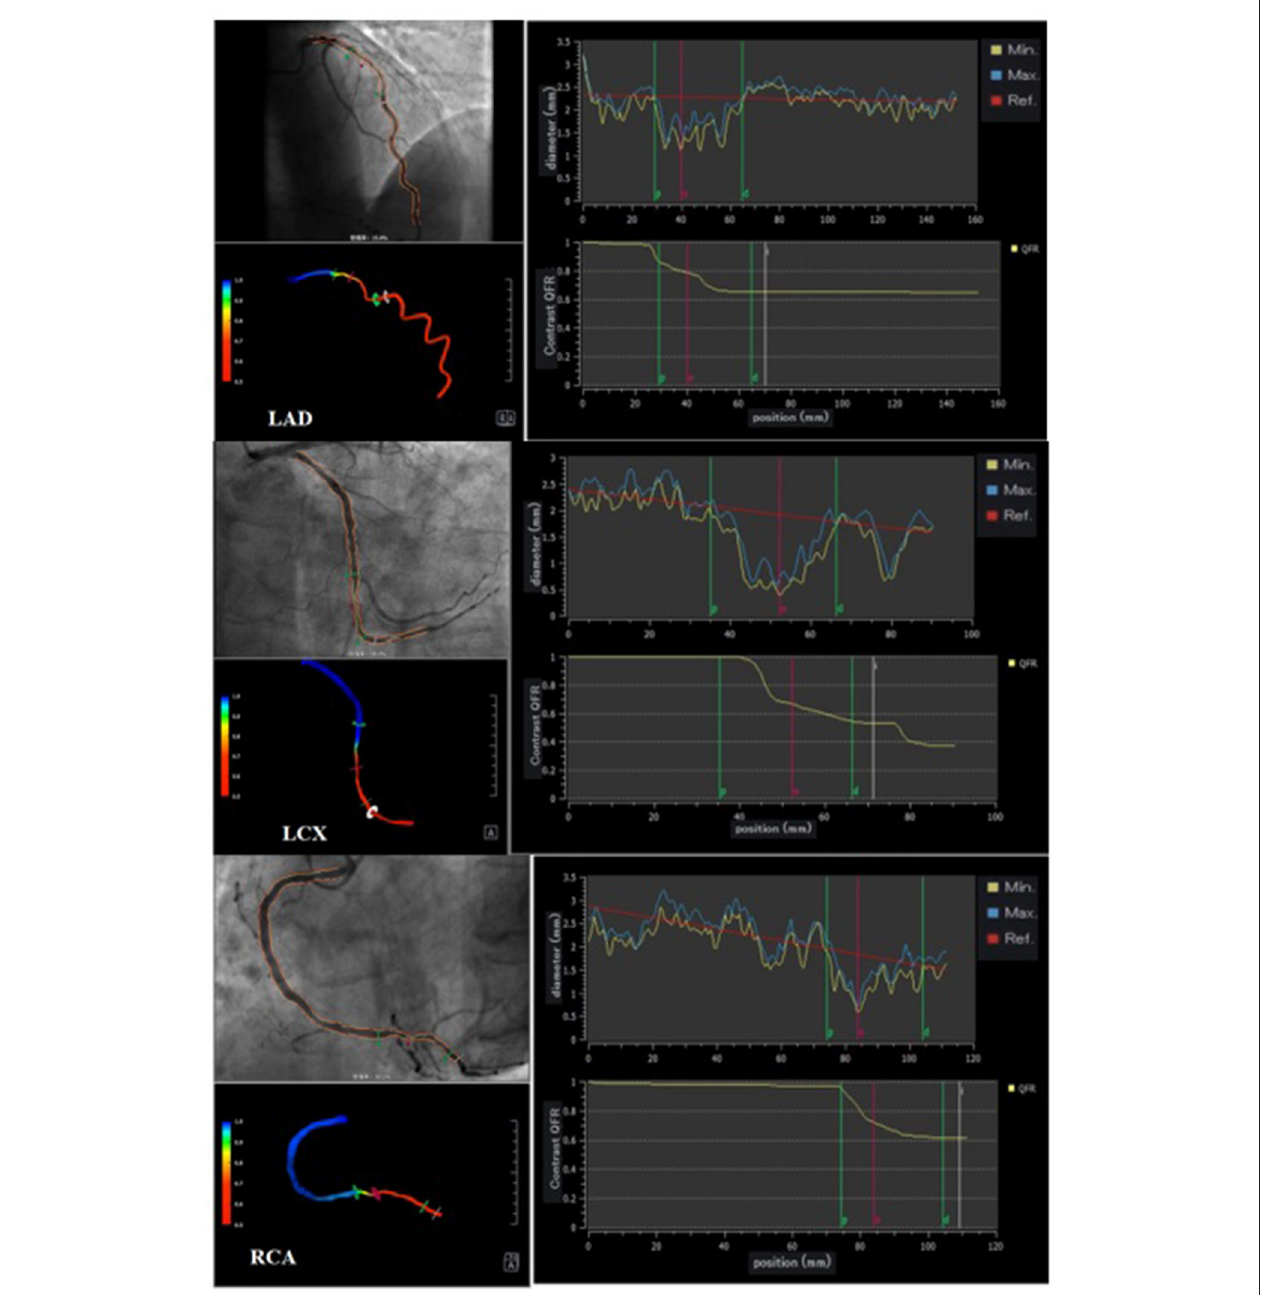
FIGURE 1 | Representative cQFR analysis. Three representative cases undergoing quantitative flow ratio (QFR) measurement. Vessel contours were delineated from two different views of coronary angiograms acquired with projection angles at a minimum of 25 ◦ apart (left upper panel). During QFR computation, quantitative image analysis of 3D reconstruction provides further insights into the quantitative anatomical parameters of each vessel (left lower panel); contrast-flow QFR (cQFR) is shown on the right panels.